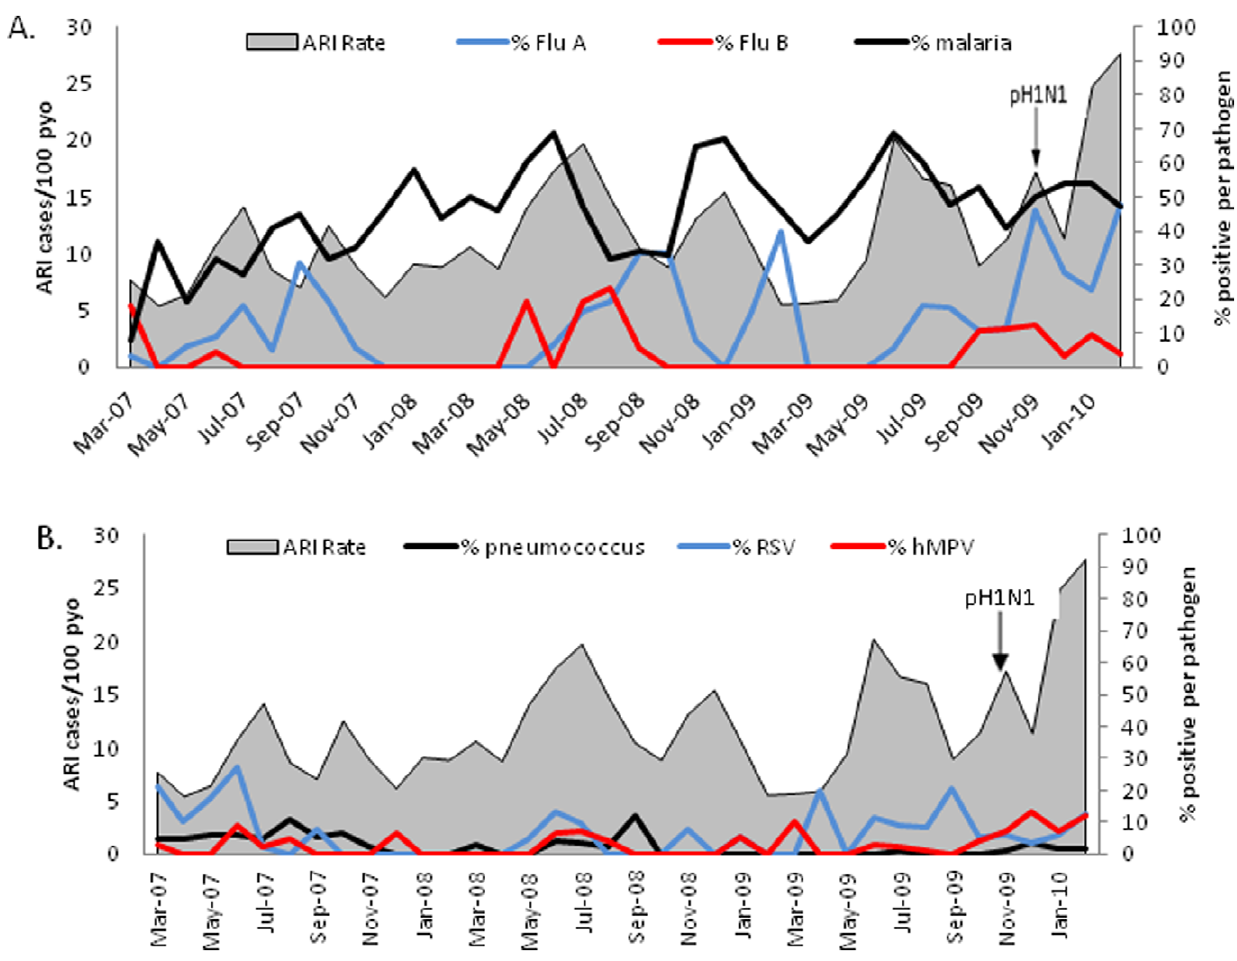
Figure 2. Monthly rates of ARI by etiology and malaria. The percent of ARI cases positive influenza viruses A and B is by qPCR and malaria by blood smear (panel A) and RSV and hMPV by qPCR and pneumococcus by blood culture (panel B), March 1, 2007-February 28, 2010. Asembo, western Kenya. Pneumococcus only given by blood culture because urine antigen testing was not available during entire time period. Pandemic H1N1 influenza virus (pH1N1) first detected at Lwak Hospital in November 2009.